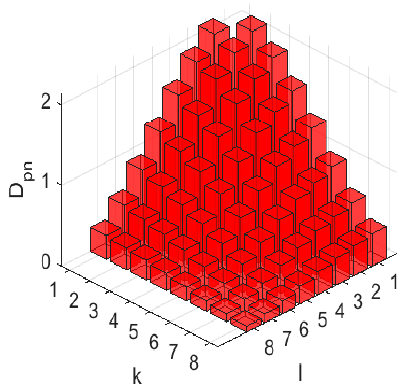
Figure 2. An example of normalized power spectrum estimate obtained in image homogeneous regions.